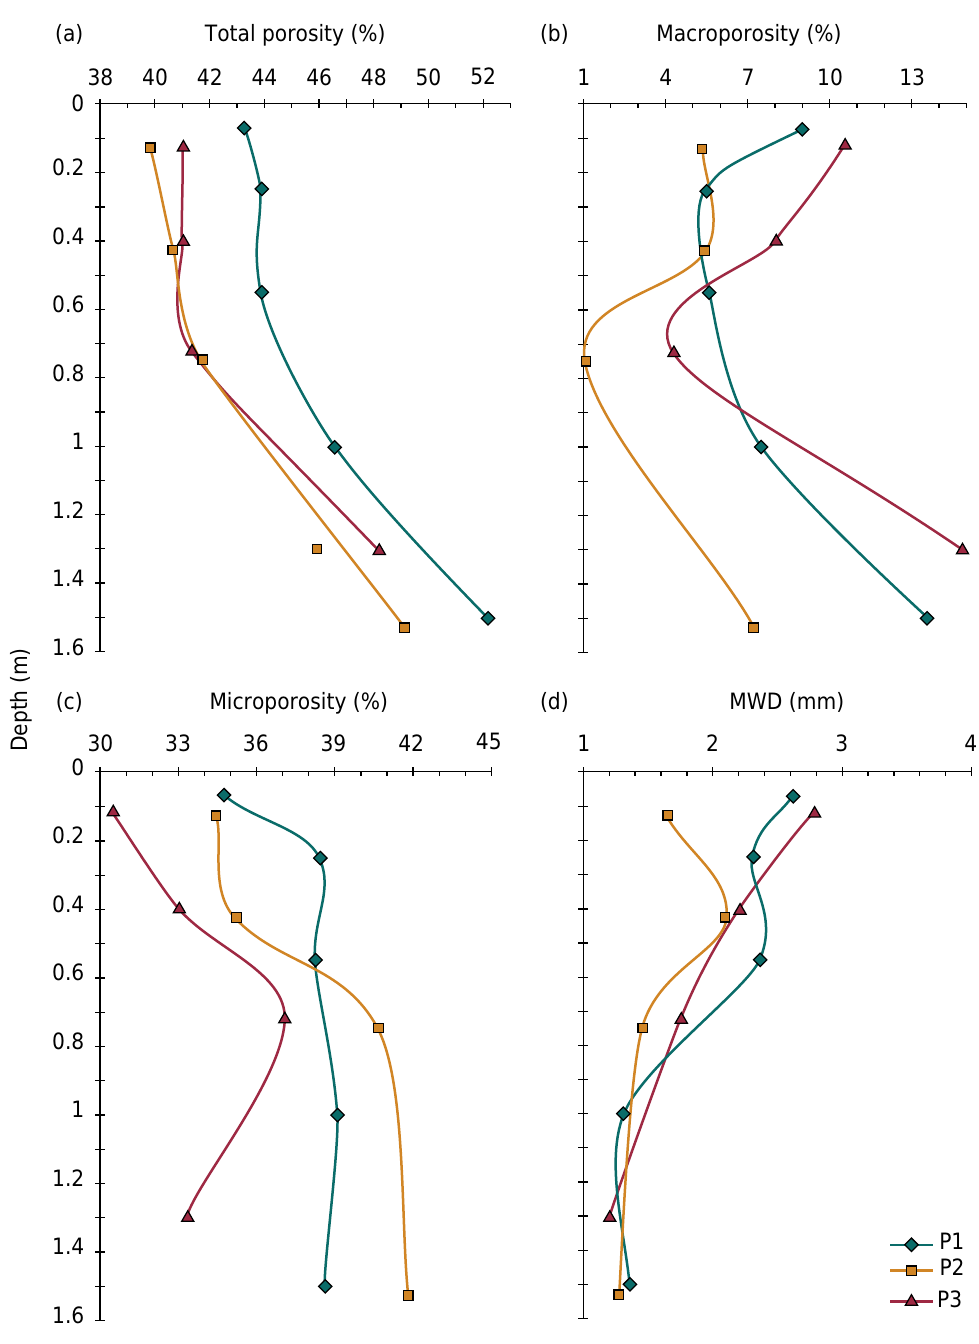
Figure 2. Values of total porosity (a), macroporosity (b), microporosity (c), and mean weight diameter (MWD) at depth in all soil profiles